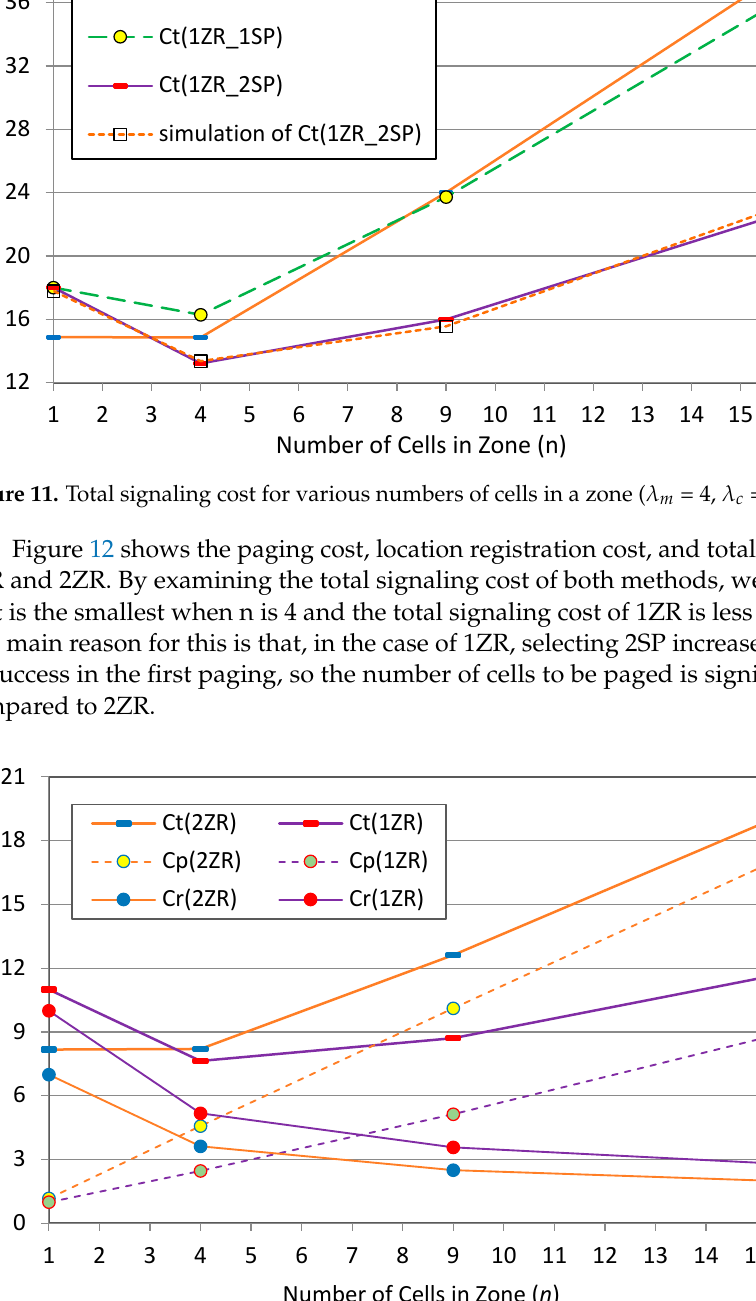
Figure 12. Total signaling cost for various numbers in a zone ( λ m = 2.5, λ c = 1, q = 0.3).